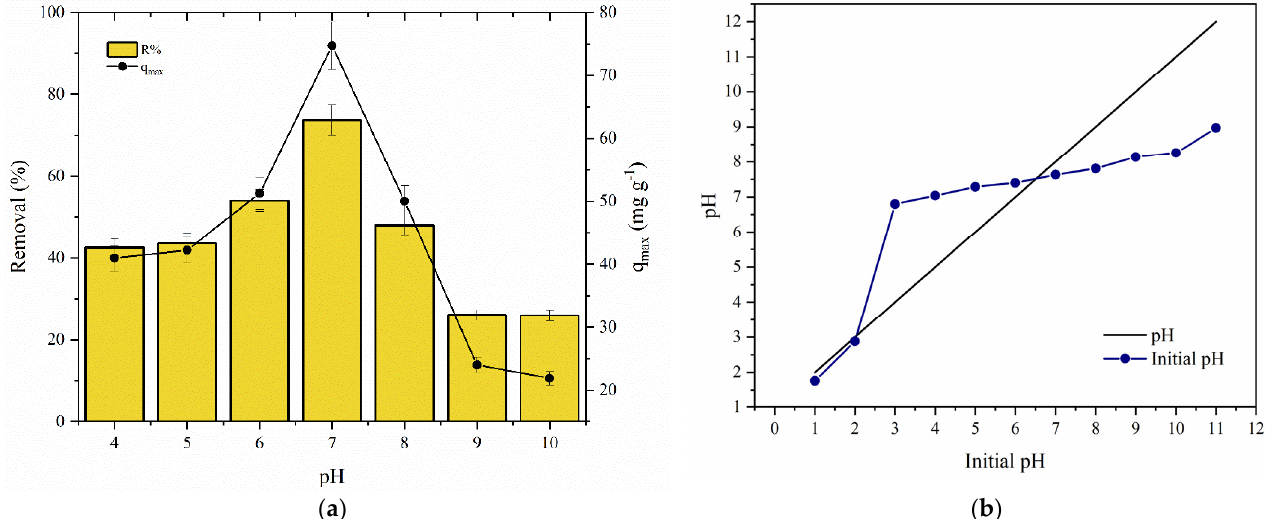
Figure 10 . ( a ) Zero point of charge of the CS·Fe 3 O 4 . ( b ) Effect of pH on TC adsorption ( C 0 = 50 mg L − 1 , pH = 4–10, adsorbent dosage = 0.5 g L − 1 , V = 100 mL, and 293.15 K). The maximum adsorption capacity and removal percentage were reached at pH